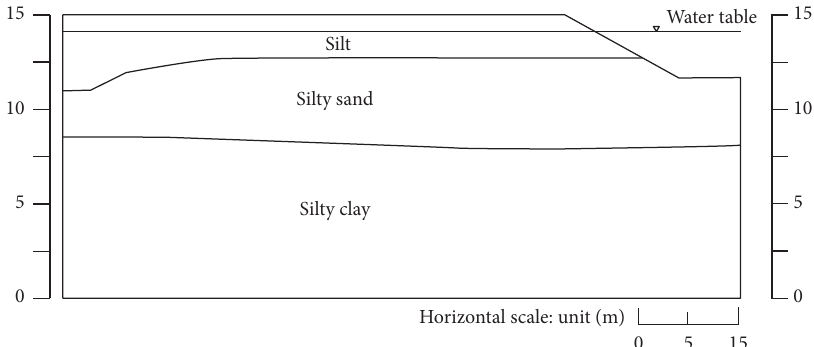
Figure 3: Soil profile after Makdisi [29] for limit equilibrium analysis.